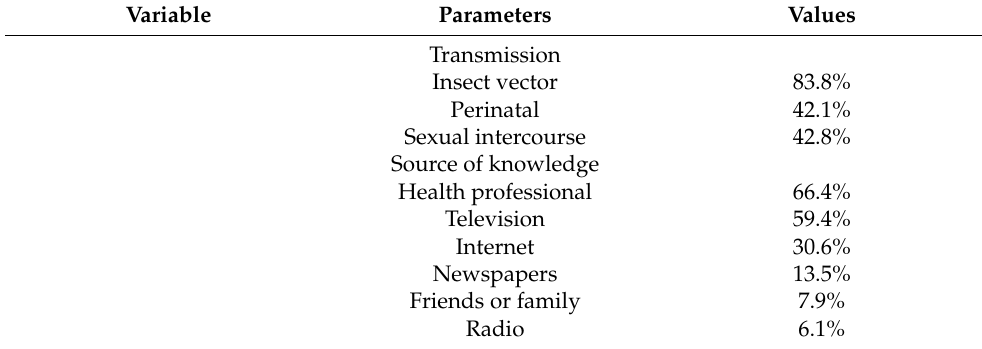
Table 2. Knowledge about ZIKV transmission.